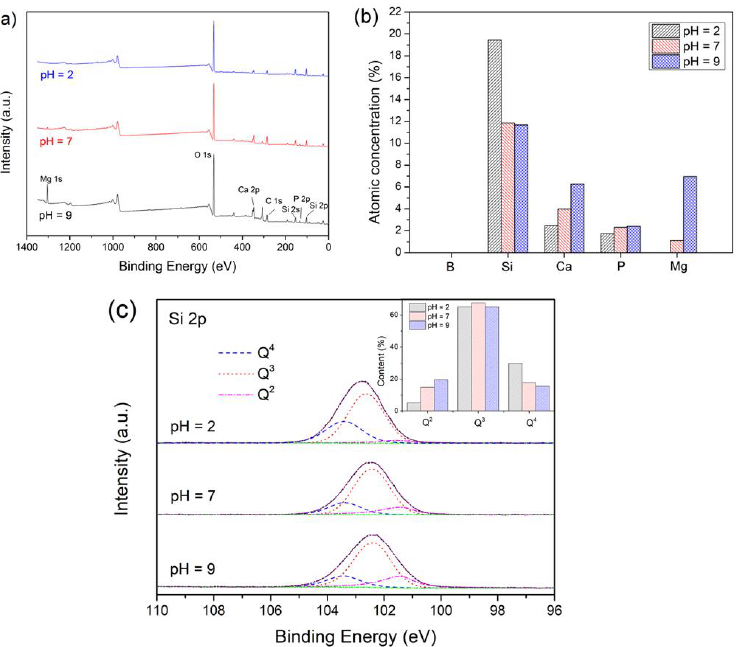
Figure 4. ( a ) XPS spectra, ( b ) representative atomic concentrations, ( c ) Si 2p spectra of the glass samples after immersion in Tris buffers with different initial pH for 6 h.